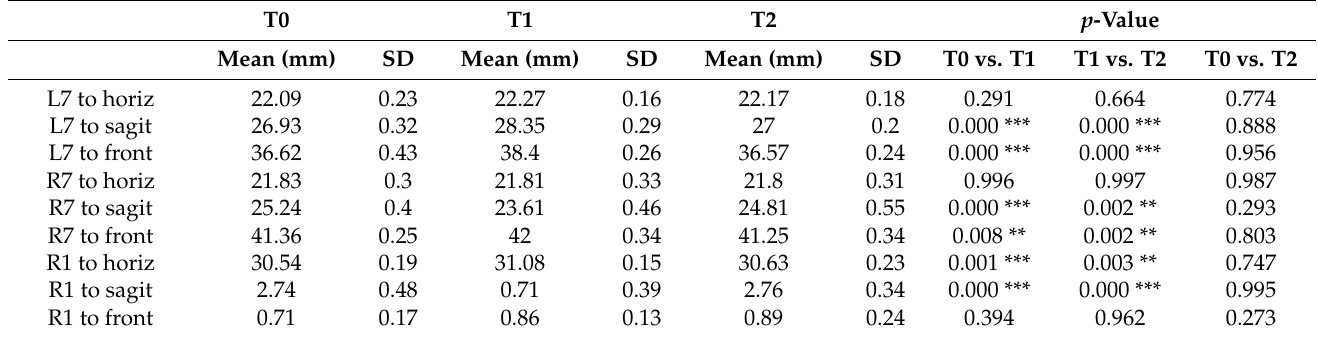
Table 4. Linear changes in mandibular dental landmarks among T0, T1 and T2.